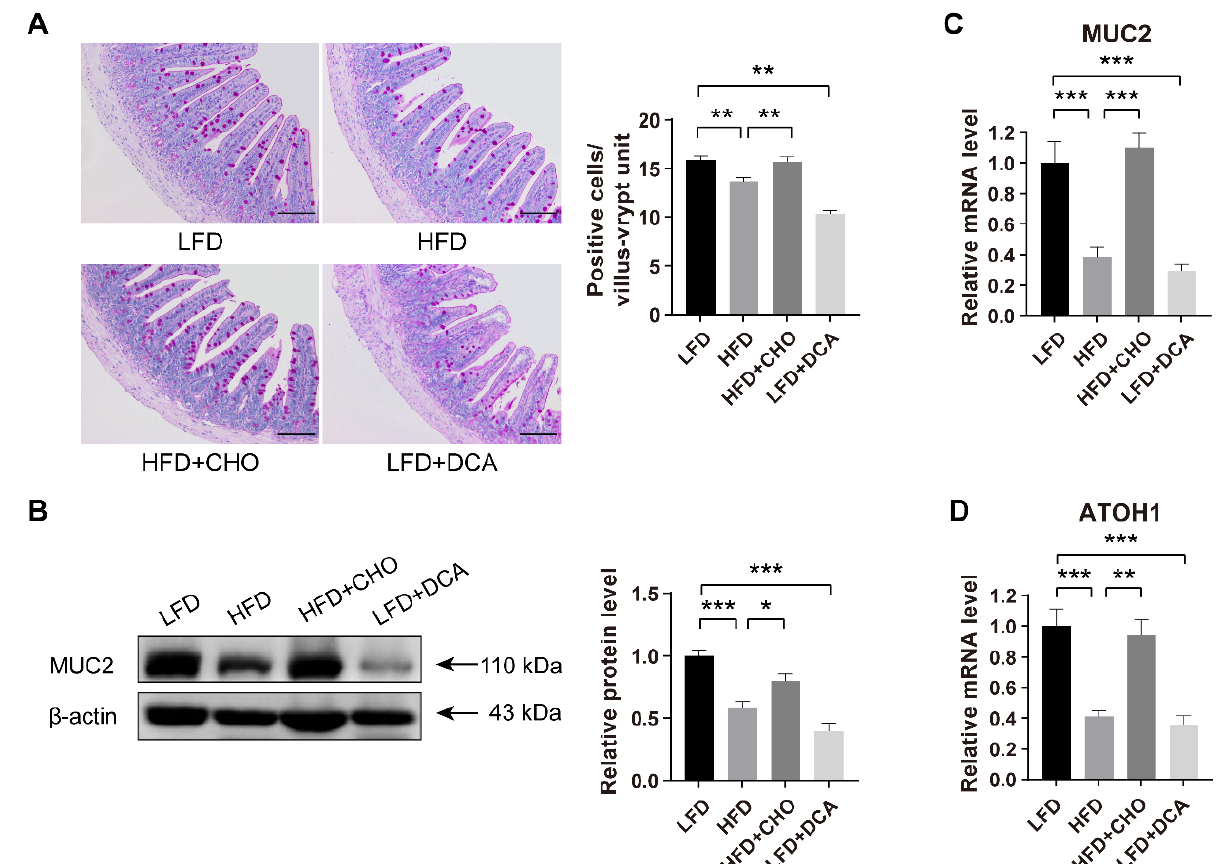
Figure 2. Elevated DCA induced by an HFD impairs the differentiation of ISCs to GCs. ( A ) PAS staining and analysis of positive cells per villus–crypt unit (n = 5); scale bars, 100 µ m. ( B ) Relative protein levels of MUC2 secreted by GCs in ileal tissue and analysis in different groups (n = 6). ( C ) Relative mRNA levels of MUC2 in ileal tissue and analysis in different groups (n = 6). ( D ) The mRNA expression levels of ATOH1, the key gene of ISC differentiation into GCs in the ileum, in different groups (n = 6). Data are shown as the mean ± SEM. PAS, periodic acid-schiff; ISCs, intestinal stem cells; GCs, goblet cells; ATOH1, atonal homologue 1; LFD, low-fat diet; HFD, high-fat diet; CHO, cholestyramine; DCA, deoxycholic acid. * p < 0.05; ** p < 0.01; *** p < 0.001.